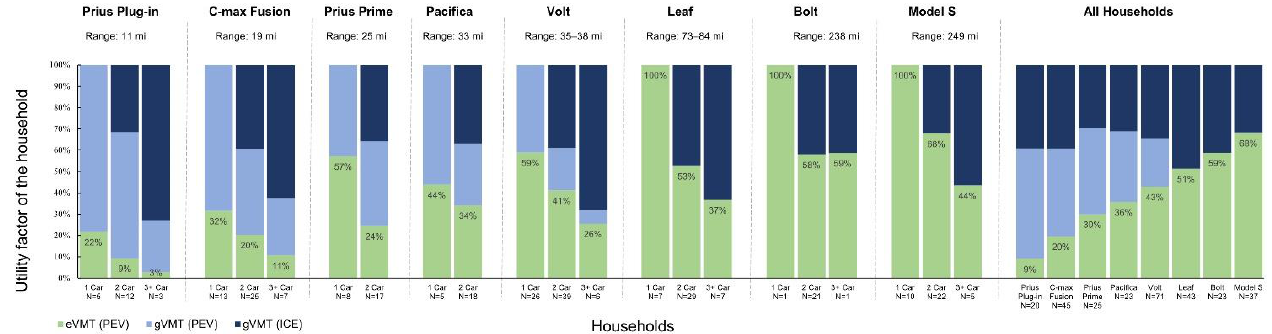
Figure 1. Utility factor of households, categorized by PEV-type and total number of cars in the household.